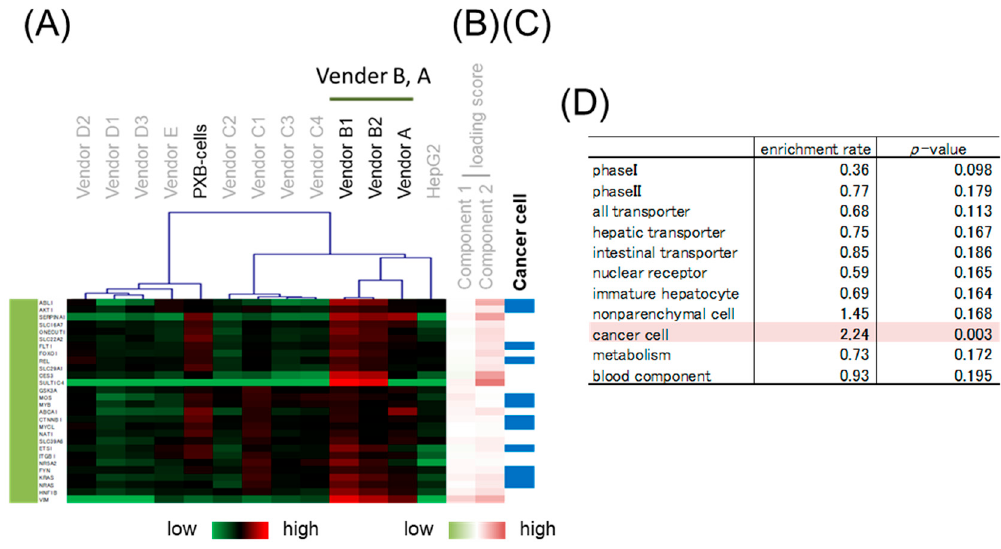
Figure 7. Enrichment analysis of the green branch. ( A ) Heatmap patterns. ( B ) PC 1 and 2 scores. Red lines exhibit plus scores, and green lines exhibit minus scores. ( C ) The blue lines exhibit genes related to cancer cells. ( D ) Enrichment rates and p -values from the chi-squared test of different gene categories. The highlighted categories are significantly enriched.